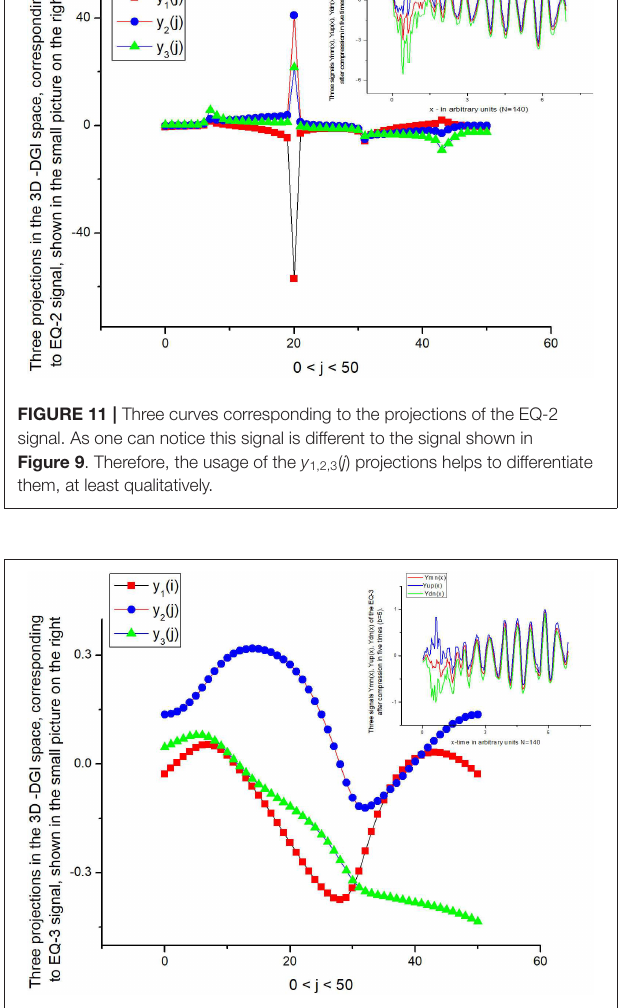
FIGURE 12 | Comparison of this figure with Figure 10 allows a preliminary conclusion about the statistical similarity of the EQ-1 with EQ-3 to be made,